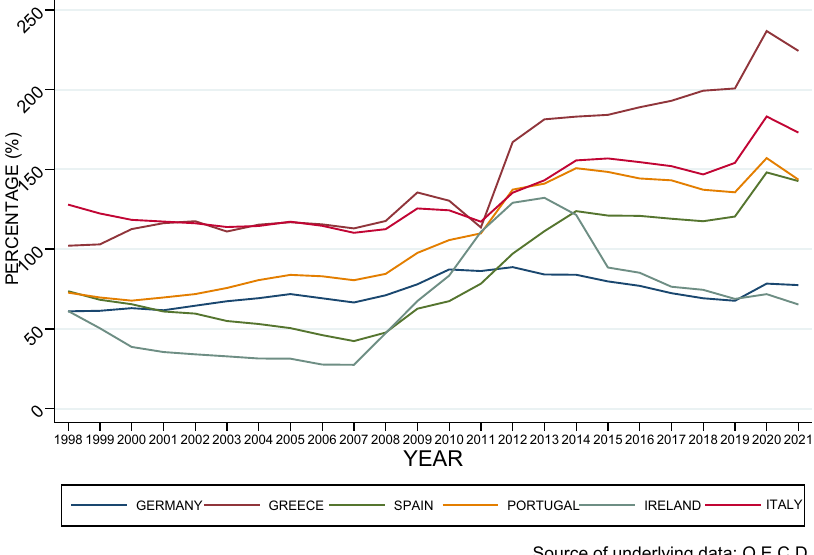
Fig. 2 Public debt-to-GDP ratios for GIIPS member states vs. Germany. This fi gure describes the recent evolution of public debt-to-GDP ratios for GIIPS economies vis-à-vis Germany ’ s ratio. Source: